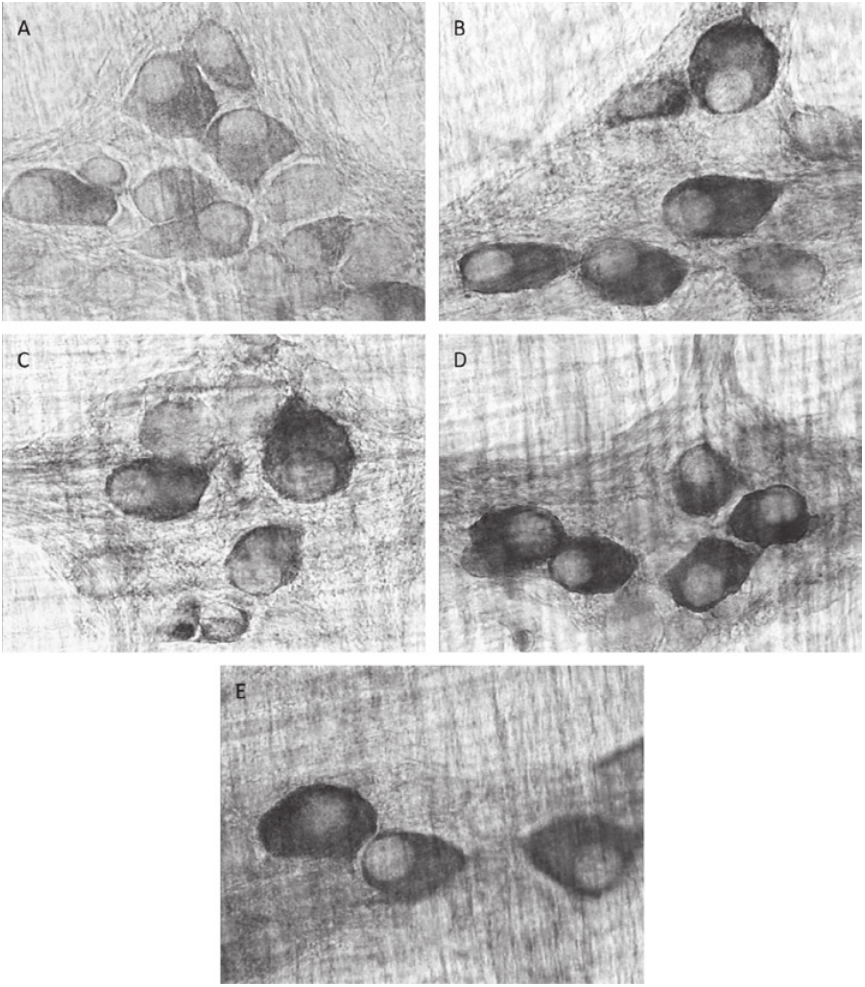
Fig. 1 - Myenteric ganglia in the duodenum of rats at different ages. (A) 90 days, (B) E345 days, (C) E428 days and supplemented with ascorbic acid (D) EA345, (E) EA428 days. Myosin-V immunohistochemistry. Image captured using a 40x lens. Calibration bar =